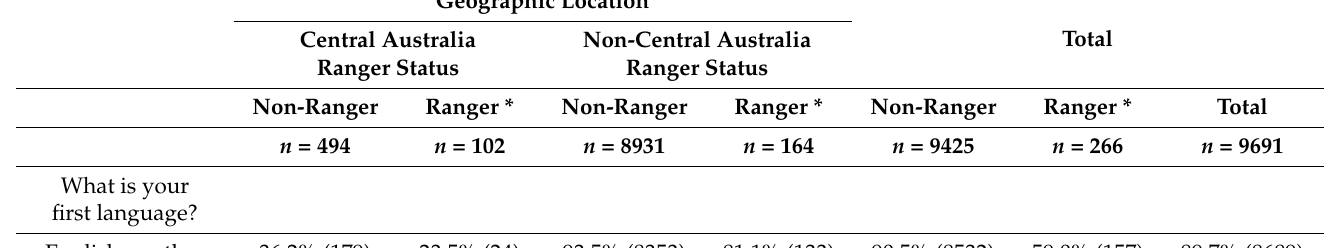
Table 3. Cultural characteristics of Rangers and non-Rangers, by geographic location. Geographic